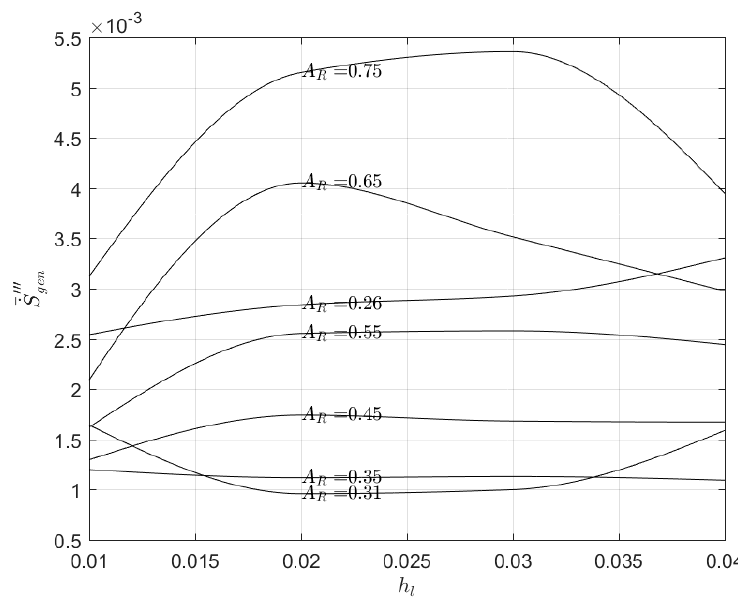
Figure 10. Dimensionless rate of total entropy generation for N = 13, and N r = 1 as a function of the height of discrete heat sources from the bottom for various aspect ratios.